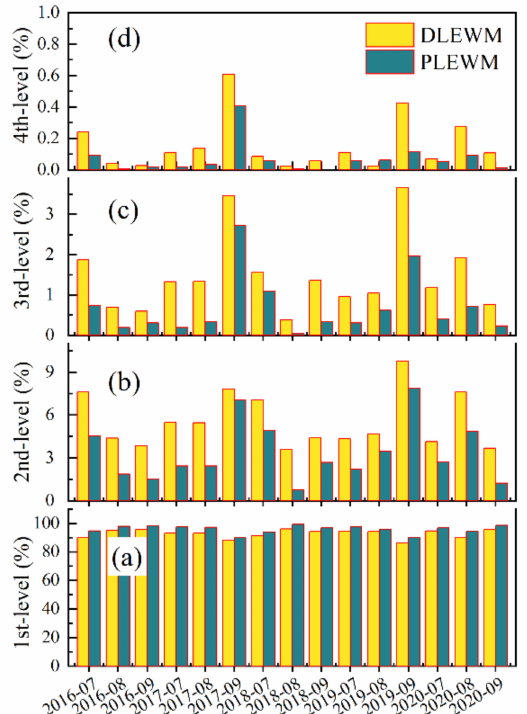
Figure 15. Percentage of warning areas issued by PLEWM and DLEWM at each level for simulated warnings for the 2016 to 2020 rainy seasons: ( a ) 1st-level, ( b ) 2nd-level, ( c ) 3rd-level, ( d )